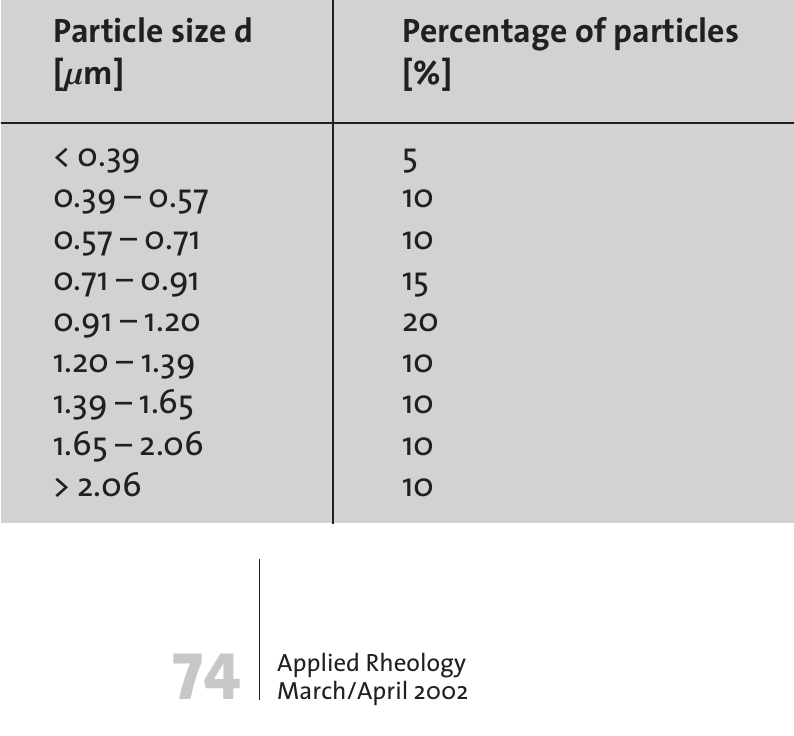
Table 1 (below): Particle size distribution of hard-metal carbide